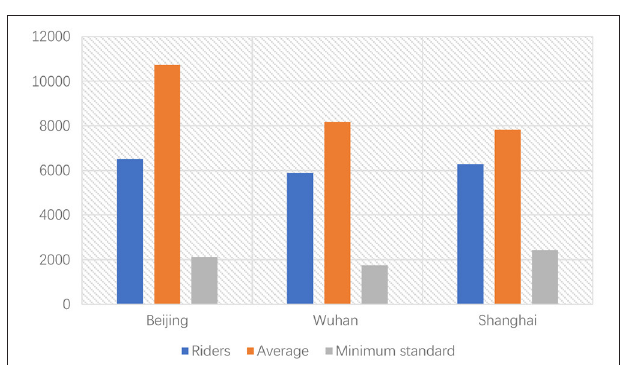
FIGURE 5 | Monthly income of riders in big